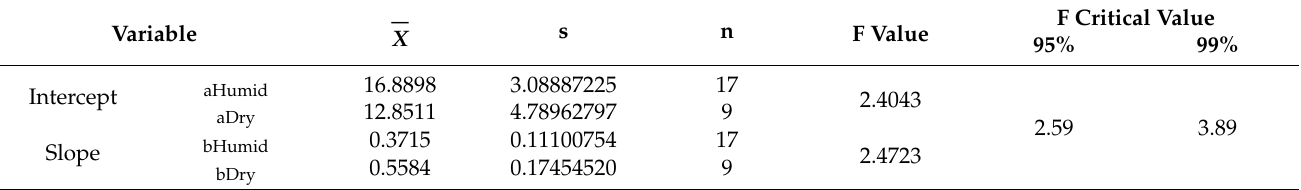
Table 8. Results of the F-test (Fisher test) for the analyzed comfort equations.